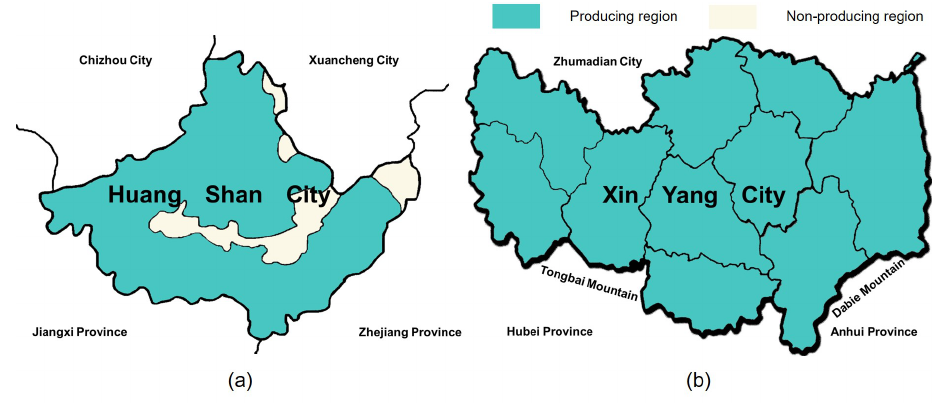
Figure 2. Protection zones for products of geographical indication. ( a ) HSMF tea in Huangshan City, Anhui Province; ( b ) XYMJ tea in Xinyang City, Henan Province.